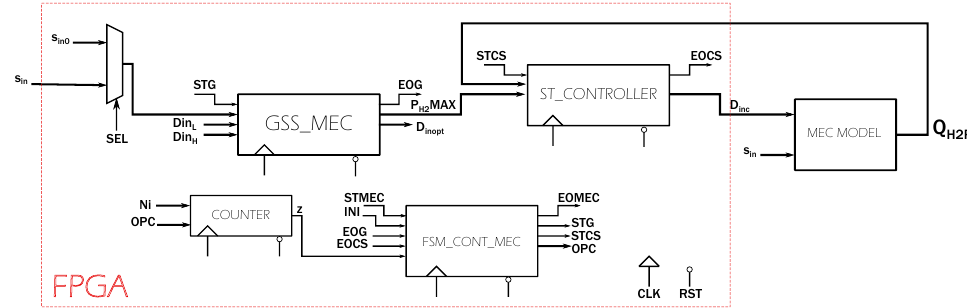
Figure 8. FPGA-based implementation of the hydrogen optimization algorithm.